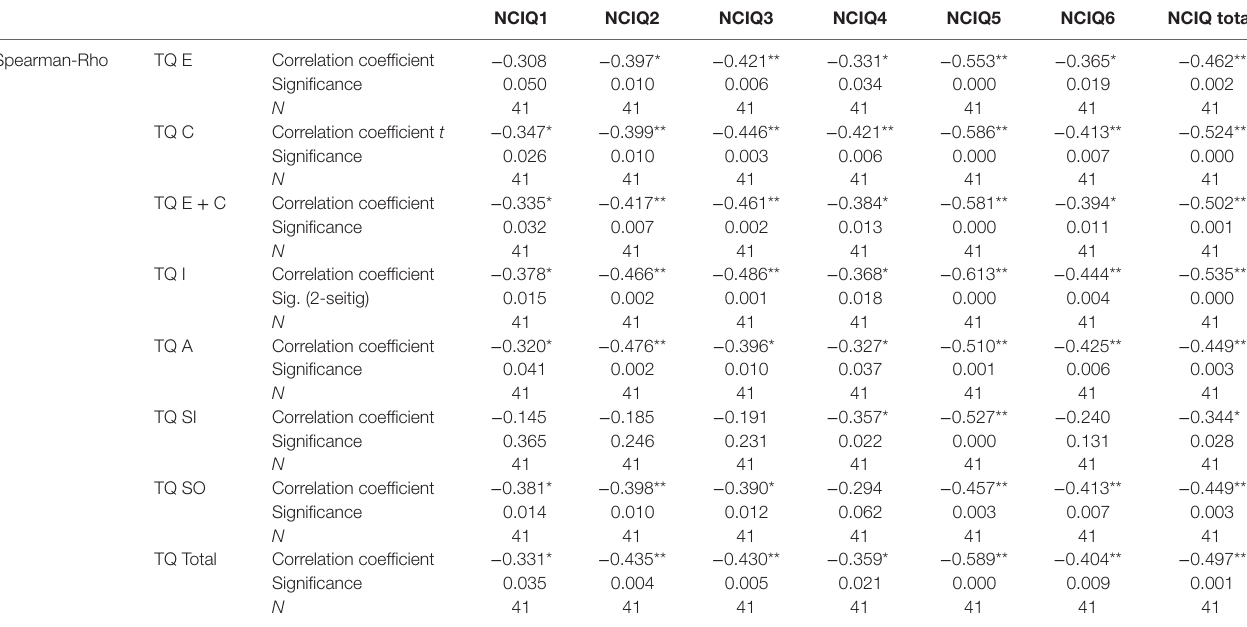
TaBle 5 | correlation between tinnitus and health-related quality of life 6 months after cochlear